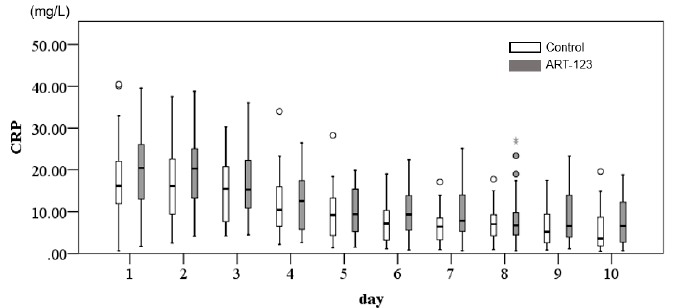
Figure 2. Changes of time course in C-reactive protein (CRP) from day 1 to day 10.